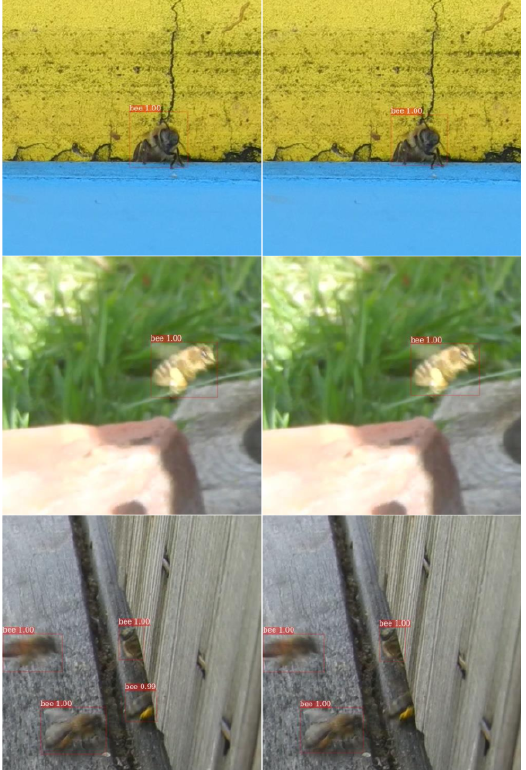
Figure 16. Bees detected by reference network ( left ) and the proposed model ( right )—image